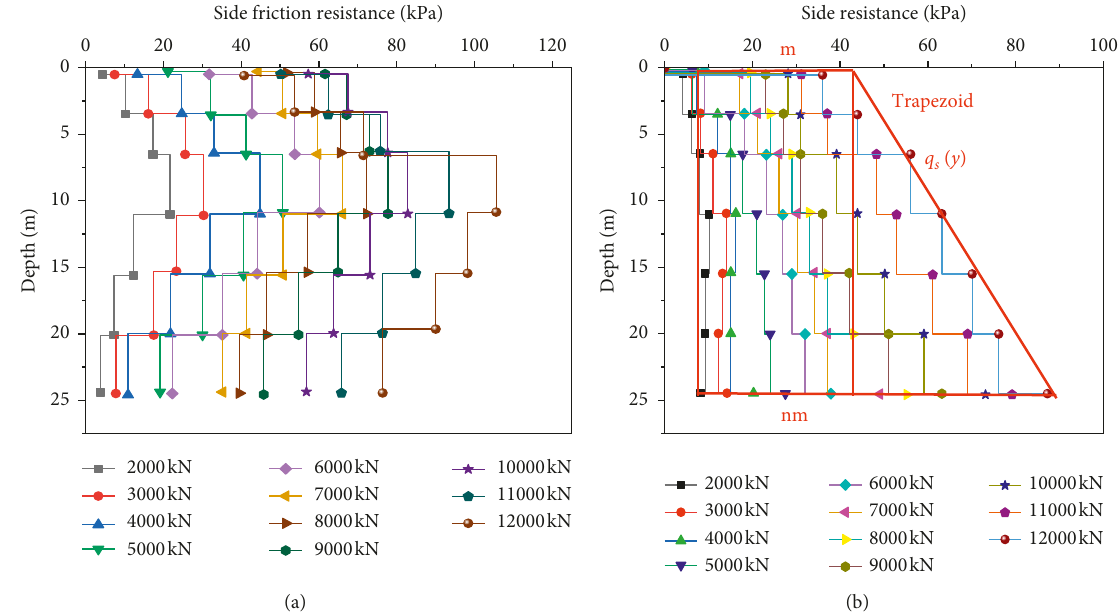
Figure 7: The frictional resistance strength diagram of (a) TS1 and (b) TS2 along the pile